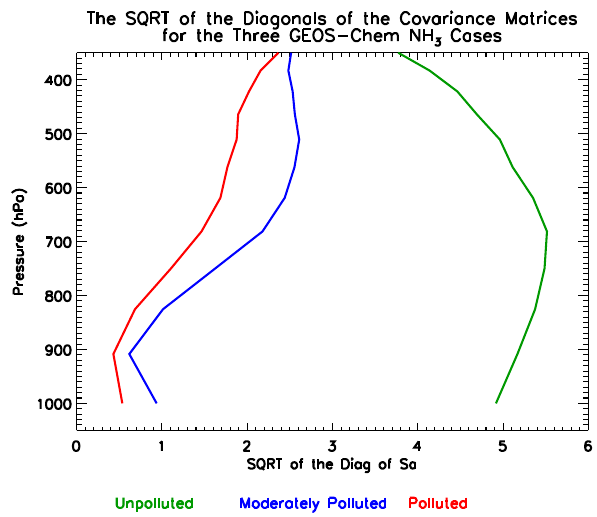
Fig. 4. The square root (SQRT) of the diagonals of the three covari- ance matrices derived from the GEOS-Chem NH 3 global monthly mean profiles (unpolluted, moderately polluted, and polluted), in lnVMR, plotted as functions of pressure.